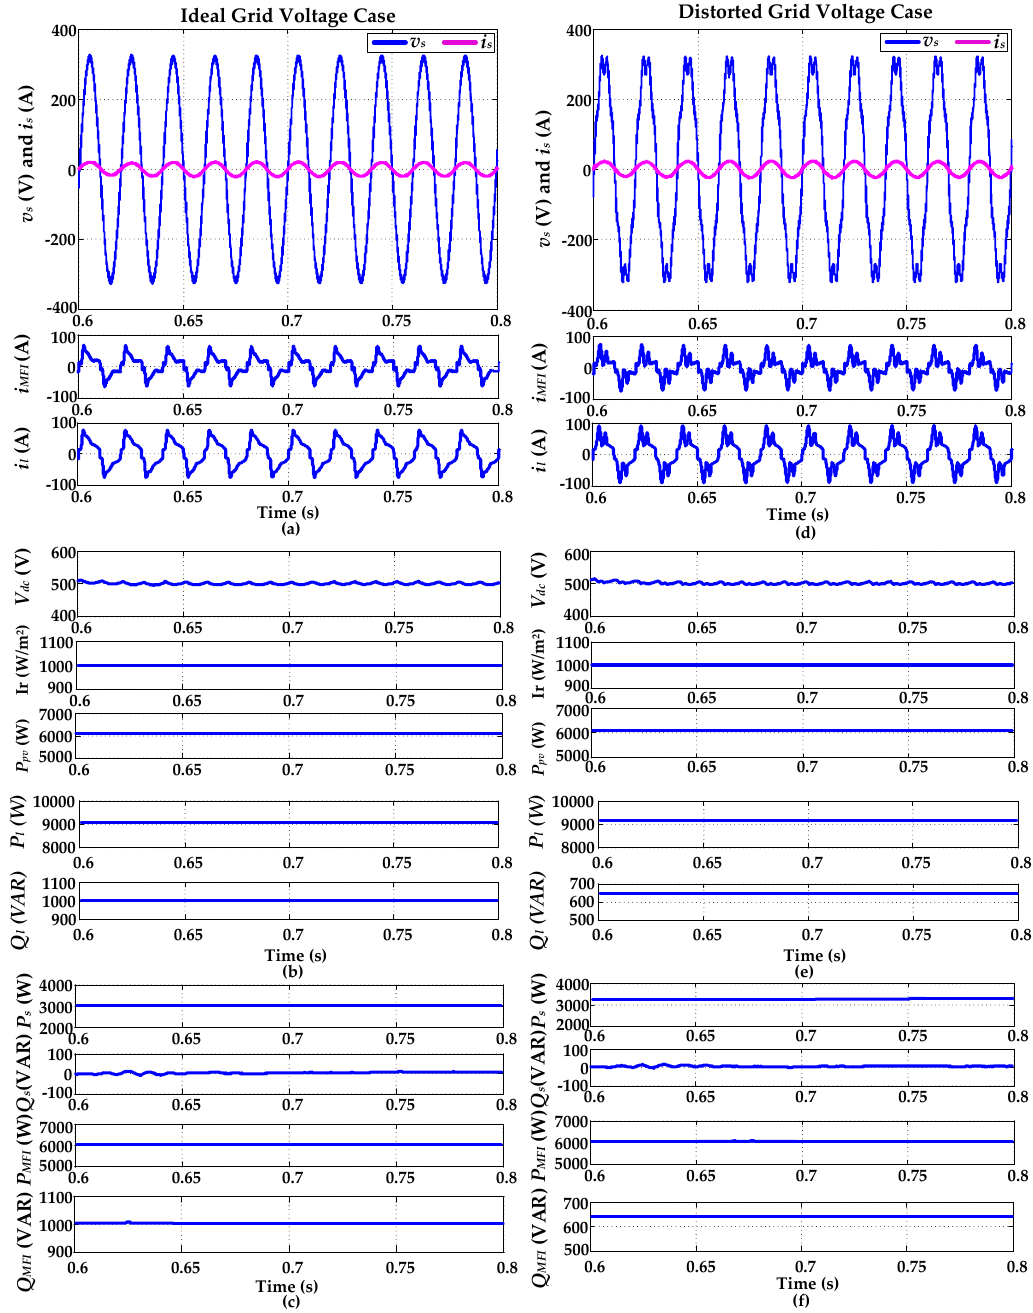
Figure 8. Simulated output waveforms under MFI ON, grid sharing, and power conditioning mode. ( a ) Ideal grid input voltage, current, MFI current, and load current; ( b ) MFI DC-link voltage, solar irradiation, PV power, and load active and reactive power under ideal grid; ( c ) source active power, reactive power, and MFI active and reactive power under ideal grid; ( d ) distorted grid input voltage, current, MFI current, and load current; ( e ) MFI DC-link voltage, solar irradiation, PV power load, and active and reactive power under distorted grid; ( f ) source active power, reactive power, and MFI active and reactive power under distorted grid.